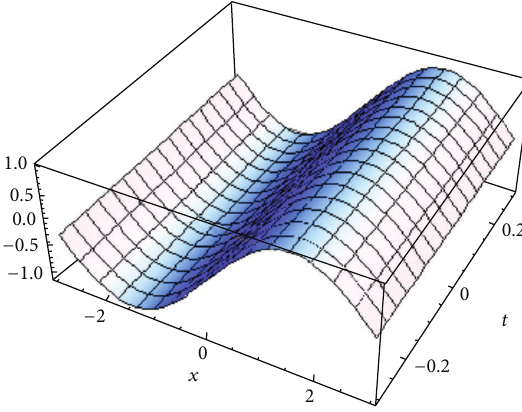
Figure 4: 3D, exact solution of 𝜂(𝑥,𝑡) at 𝑡 = 0.1